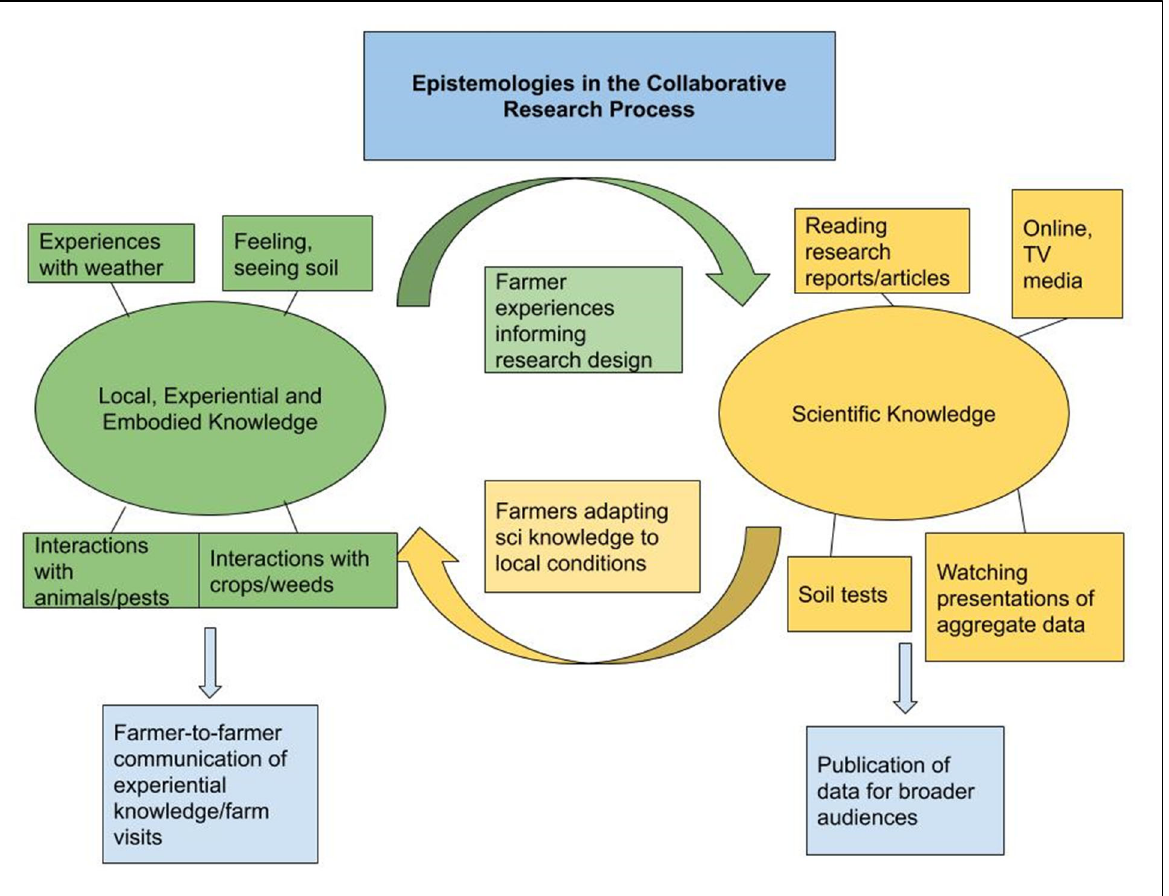
Figure 2. The Use of Scientific and Experiential Knowledges by Participants in the Dry Farming Collaborative Research